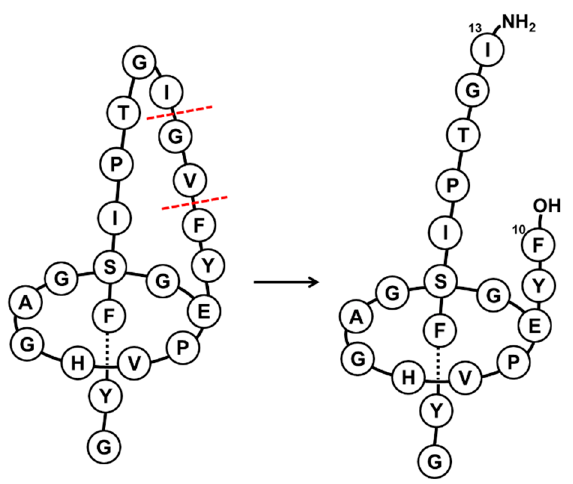
Figure 2. Schematic representation of thermolysin cleavage in the native MccJ25 and in the new compound. Dashed red lines indicate the cleavage sites.